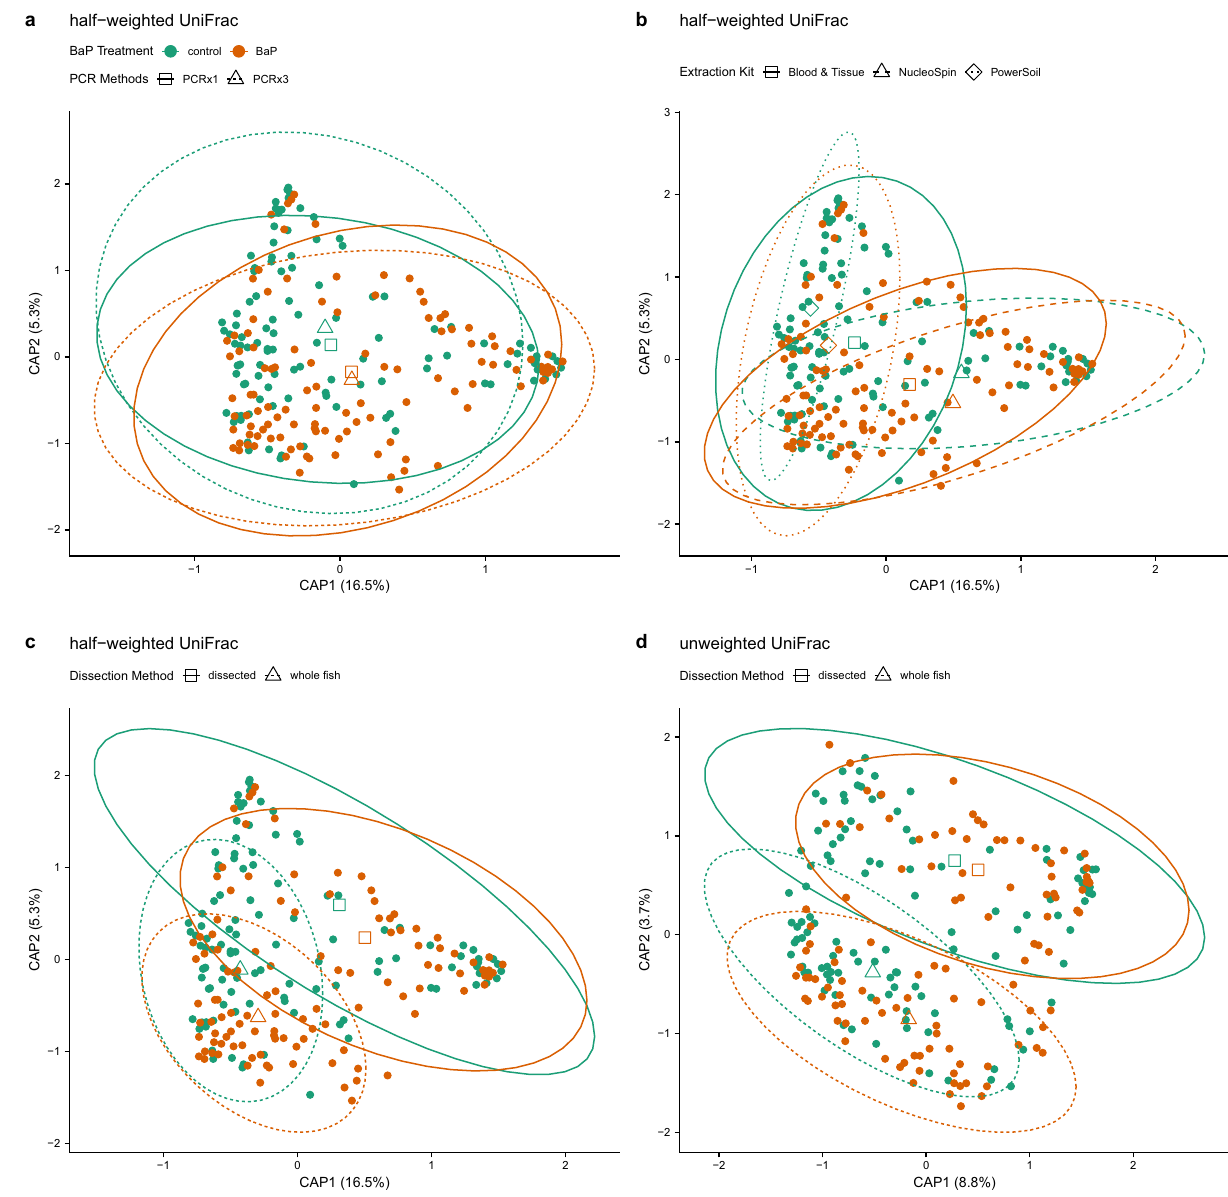
Figure 3. dbRDA ordinations of differences in zebrafish microbiome composition (beta-diversity) highlighting various significant associations between differences in composition and methodology. In all panels, solid points are colored by BaP treatment, open shapes (triangles, diamonds, squares) indicate centroids of each BaP treatment by processing method interaction, and ellipses demarcate 95% C.I.s for these centroids. Panels a-c depict identical half-weighted UniFrac ordinations with different statistical associations highlighted. ( a ) BaP exposure and PCR replication (1x vs. 3x); open squares and solid lines indicate centroids and their 95% C.I.s for single PCR samples, open triangles and dashed lines indicate centroids and their 95% C.I.s for triplicate PCR samples. ( b ) BaP exposure and DNA extraction kit; open squares and solid lines indicate centroids and their 95% C.I.s for Blood & Tissue-extracted samples, open triangles and dashed lines indicate centroids and their 95% C.I.s for NucleoSpin-extracted samples, and open diamonds and dotted lines indicate centroids and their 95% C.I.s for PowerSoil-extracted samples. ( c ) BaP exposure and dissection method; open squares and solid lines indicate centroids and their 95% C.I.s for dissected intestine samples, open triangles and dashed lines indicate centroids and their 95% C.I.s for whole fish samples. Panel ( d ) depicts an unweighted UniFrac ordination with the statistical interaction between BaP and dissection method highlighted with the same information overlaid as in panel ( c